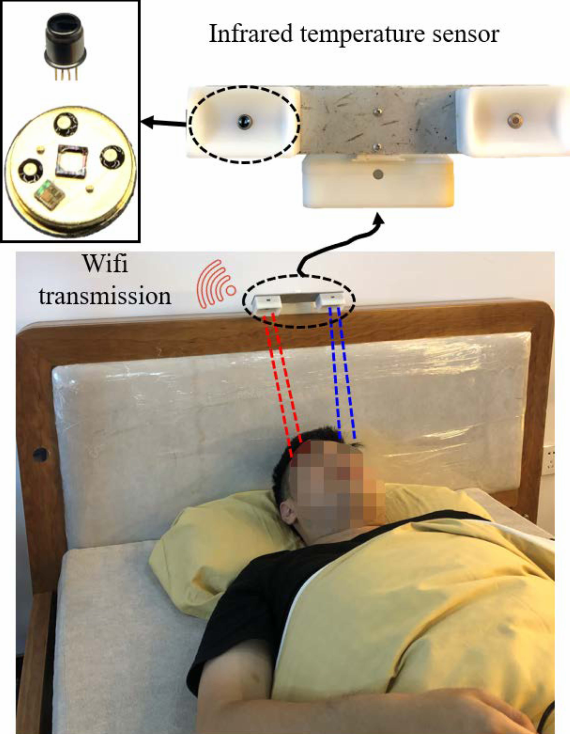
Figure 13. Schematic diagram of temperature sensing device